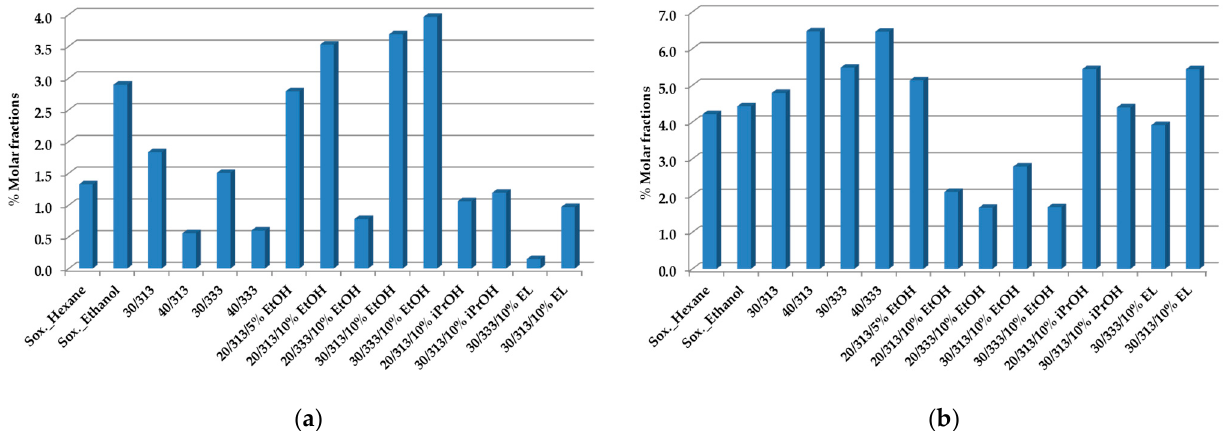
Figure 2. Ca ff eine ( a ) and cafestol ( b ) composition of spent co ff ee oils obtained by Soxhlet with Figure 2. Caffeine ( a ) and cafestol ( b ) composition of spent coffee oils obtained by Soxhlet with hexane, ethanol, and scCO 2 extraction at a fl ow rate of F = 1.8 × 10 − 3 kg·min − 1 , as established by 1 H- hexane, ethanol, and scCO 2 extraction at a flow rate of F = 1.8 × 10 − 3 kg · min − 1 , as established by NMR quantitative analysis [50]. All values represent % molar fractions. 1 H-NMR quantitative analysis [50]. All values represent % molar